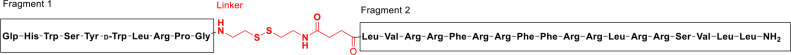
The structure of target conjugate.